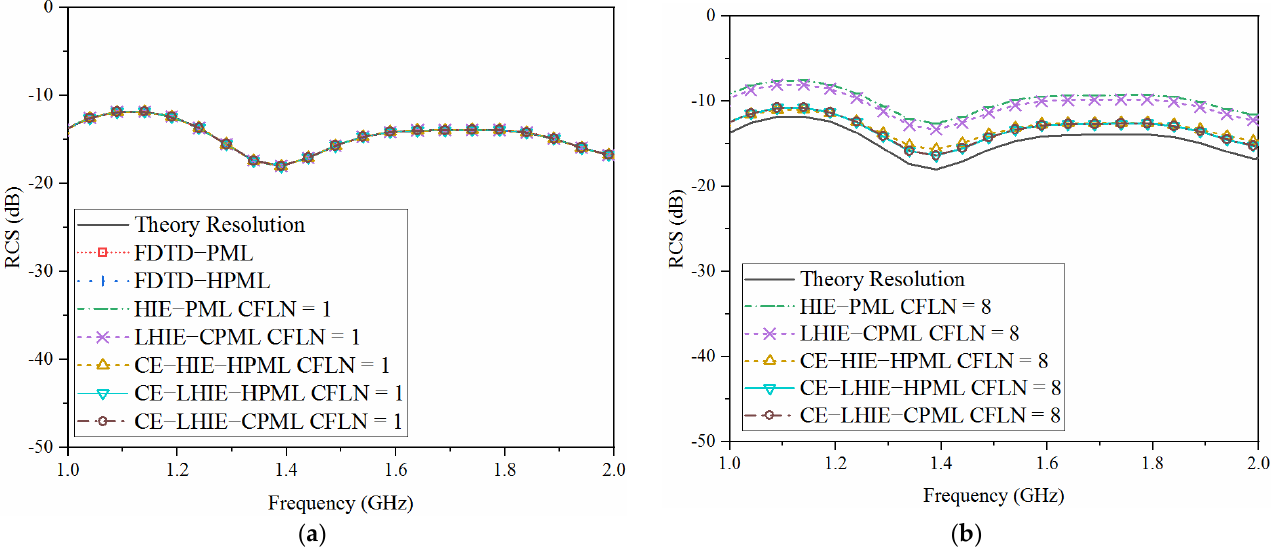
Figure 10. Radar cross section obtained by different PML algorithms: ( a ) CFLN = 1; ( b ) CFLN = 8. Table 4. The computational duration, consumption memory, iteration step, memory increment and time reduction obtained by different PML algorithms in the sphere model.